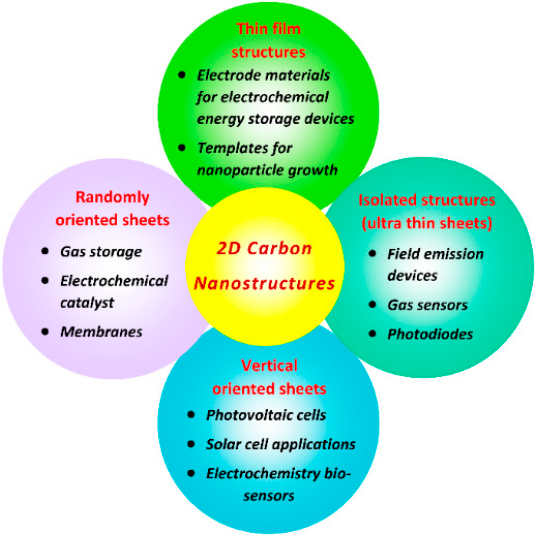
Figure 14. Schematic representations of possible applications of CNWs/other 2D carbon materials.